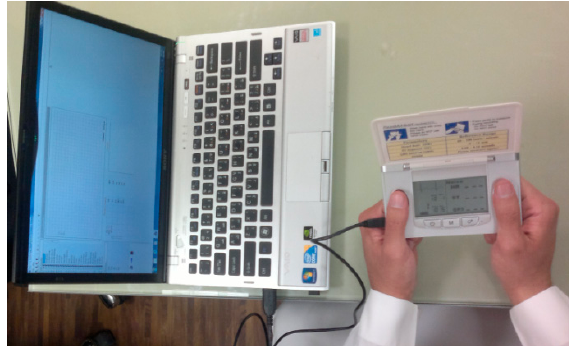
Figure 9. ECG data collection using the ReadMyHeart device.